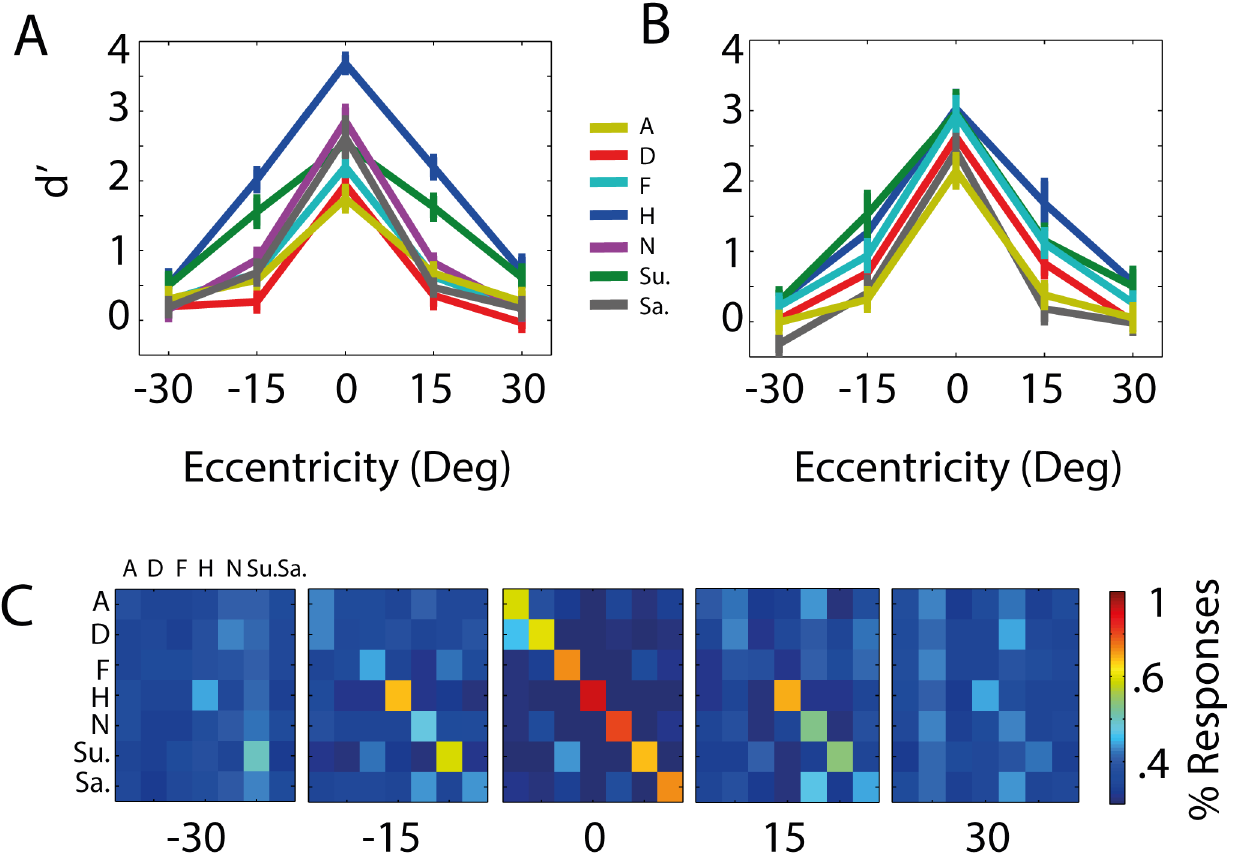
Fig 1. Performance in the expression recognition and detection tasks. (A) Expression Recognition: Average d’ scores as a function of eccentricity of stimulus presentation, for each basic facial expression category plus neutral (A = Anger; D = Disgust; F = Fear; H = Happy; N = Neutral; Su. = Surprise; Sa. = Sad). Error bars represent standard error of the mean. (B) Expression Detection: Average d’ scores as a function of eccentricity of stimulus presentation, for each basic facial expression category (A = Anger; D = Disgust; F = Fear; H = Happy; Su. = Surprise; Sa. = Sad). Error bars represent standard error of the mean. (C) Full confusion matrices underlying performance at each eccentricity for the Emotion Recognition Task (rows = expression presented; columns = response chosen).